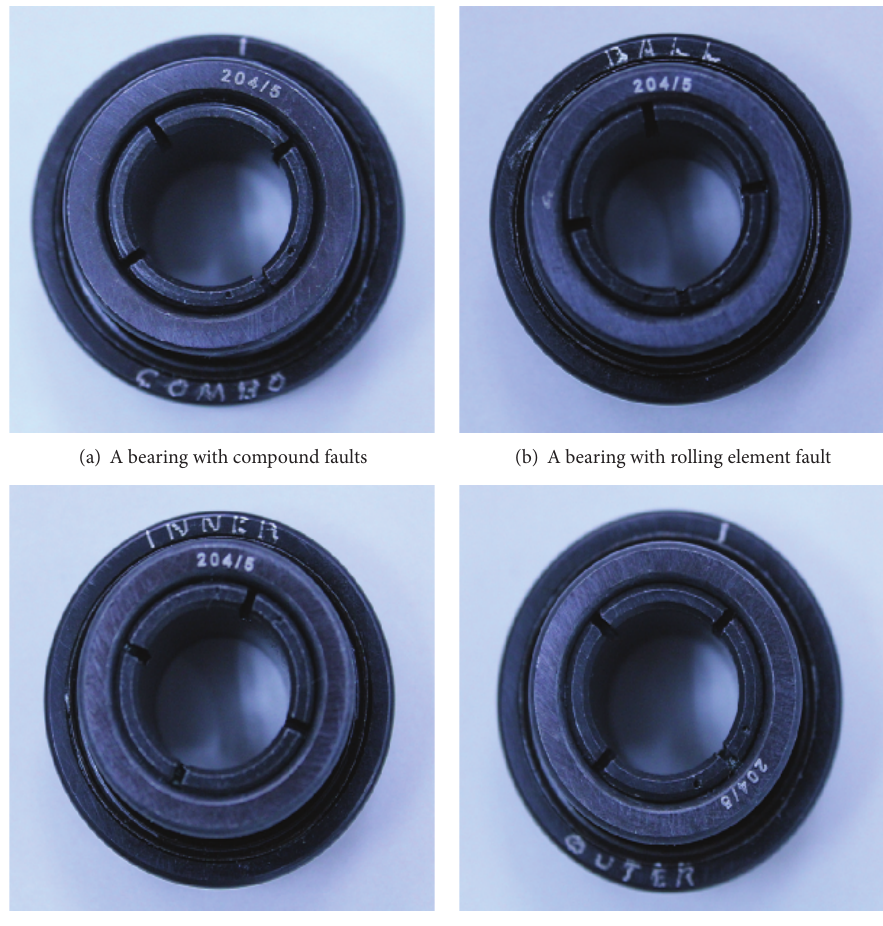
Figure 3: Bearings with typical faults.